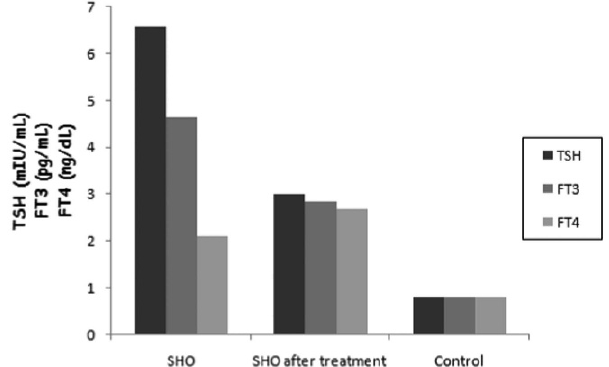
Figure 3 - Comparison of pre-treatment and post-treatment TSH, FT3 and FT4 values of patients with Subclinical Hypothyroidism and healthy control group. Abbreviation: SHO, subclinical